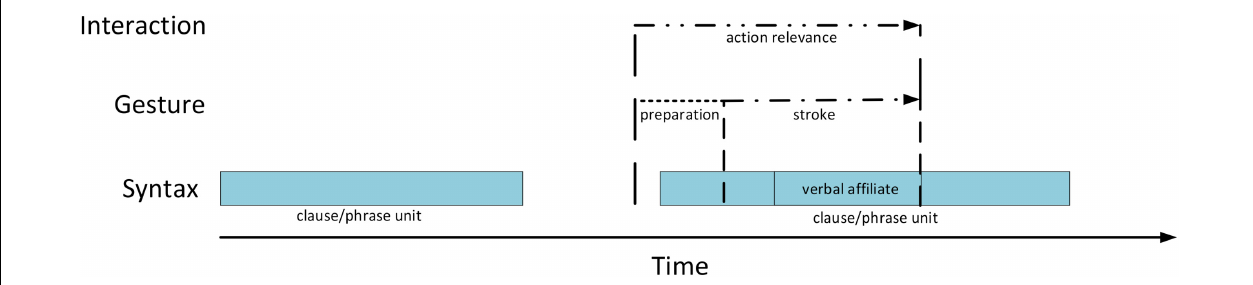
Figure 4 | Temporal unfolding of generic pre-verbal gestures in their interactional and syntactic